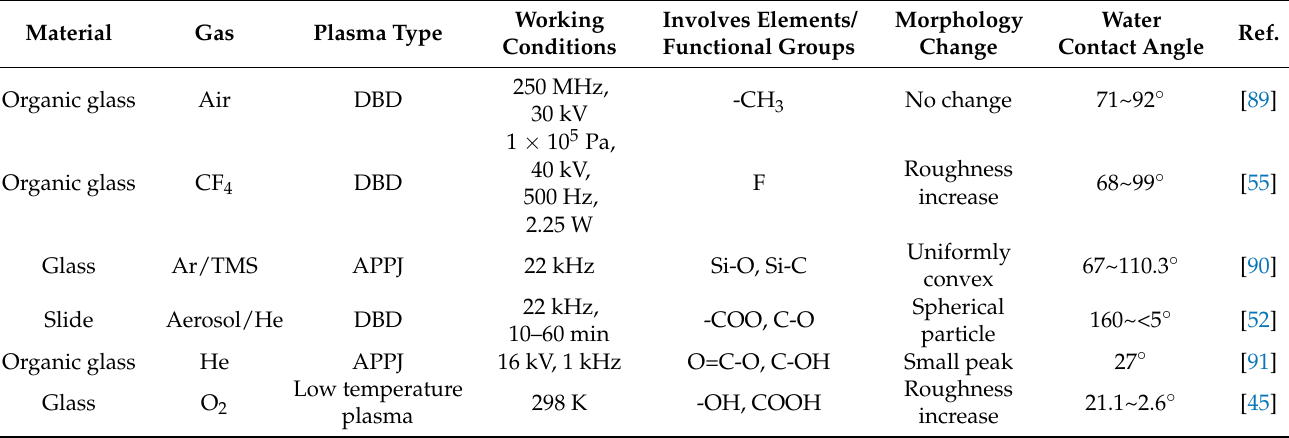
Table 5. Plasma treatment of glass surface.